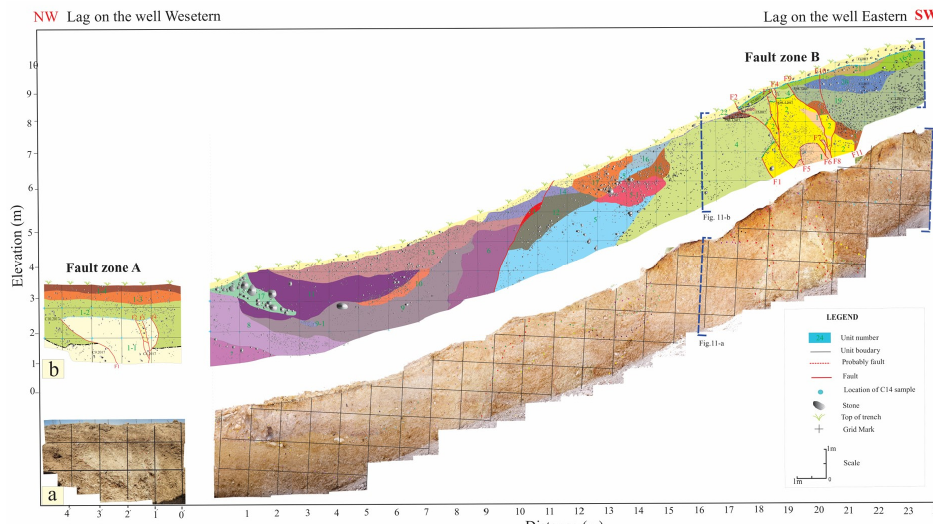
Figure 11. ( a ) Photomosaic and ( b ) interpretative log of the western wall of (zones A and B) the re-occupied archeological trench in Darbe-Astaneh prehistoric site. Event horizons are shown by a colored dashed line in Logs. Colors allow following the correspondence of the different stratigraphic units between the 2 zones. Description of Zone A: U1-1 (cid:48) : Cream to light brown, 30% clast (2 mm to 2 cm), sub-rounded, sub-angular, clay and silt matrix, loose to medium compact, rootlet structures, non-stratify. U2-2 (cid:48) : Light brown, 40% clast (1 mm to 5 cm), rarely 10 cm, some part medium compact, subrounded, subangular, silt and clay matrix, organic material, non-stratified, non-rootlet structures. U3-3 (cid:48) : Brown, matrix-supported, non-laminated, 12% clast (2 mm to 10 cm), wet sediment, include spring in the bottom, include marl and clay lens, organic material, sub-rounded, rootlet structures, clay matrix. Units in Zone B: U1: This unit corresponds to an undifferentiated Neogene formation including yellow to green marl deposit, matrix-supported, about 30% clast (2 mm to 3 cm and rarely up to 7 cm); sub-angular to sub-rounded; poorly sorted; oligomictice; massive and medium compact; wet with root in some part. U2: Similar unit U1 includes light brown to brown deposit; matrix-supported; 30% clast (2 mm to 3 cm and rarely up to 23 cm); sub-angular to sub-rounded; poorly sorted; oligomictice; massive with cracks from losing water, compact matrix; clay and silt as a matrix with root structures. U3: Dark brown deposit; matrix-supported; 15% clast (2 mm to 2 cm and rarely up to 10 cm); sub-rounded; poorly sorted; compact matrix; clay and silt as a matrix with root structures; polymictice; massive; include cracks from losing water; some in unit 1 include organic material (C 14 ) in some part. U4: Red to dark brown deposit; matrix-supported; 5% clast (2 mm to 2 cm and rarely up to 10 cm); sub-rounded; poorly sorted; compact matrix; clay and silt as a matrix with root structures; polymictice; massive; include organic material (C 14 ) in some part. U5: Green to red deposit, 4% clast (2 mm to 3 cm and rarely up to 7 cm); similar to unit 4; include cracks from lost water; clay and silt matrix, sub-rounded; poorly sorted; compact; clay and silt as a matrix with root structures; polymictic; massive; some part include organic material (C 14 ) in some part. U6: Green to light brown deposit; collapse caused to fault spring at the base unit; supported matrix; 2% clast (2 mm to 1 cm and rarely up to 4 cm to 12 cm on the top at the unit); medium compact; sub-angular; sub-rounded; poorly sorted. U7: Light brown deposit; massive; matrix-supported; 40% clast (2 mm to 3 cm and rarely up to 8 cm in some parts); sub-angular to sub-rounded; poorly sorted; some organic material; rootlet structure. U8: Cream to light brown deposit; massive; compact; matrix-supported; 40% clast (2 mm to 3 cm and rarely up to 40 cm); sub-angular to sub-rounded; poorly sorted; some organic material; rootlet structure; include gravel lines. U9: Gravely lines; green to brown deposit; massive; grain-supported; clast (2 mm to 4 cm); sub-rounded; sub-angular; medium compact; poorly sorted. U10: Light brown to green deposit; matrix-supported; clay and silt matrix; clast (2 mm to 1 cm and rarely up to 10 cm); organic material; rootlet structure; medium compact; sub-rounded. U11: Light brown deposit; grain support; medium compact; 60% clast (3 mm to 4 cm and rarely up to 10 cm); sub-rounded; sub-angular, organic material; rootlet structure; medium sort; clay and